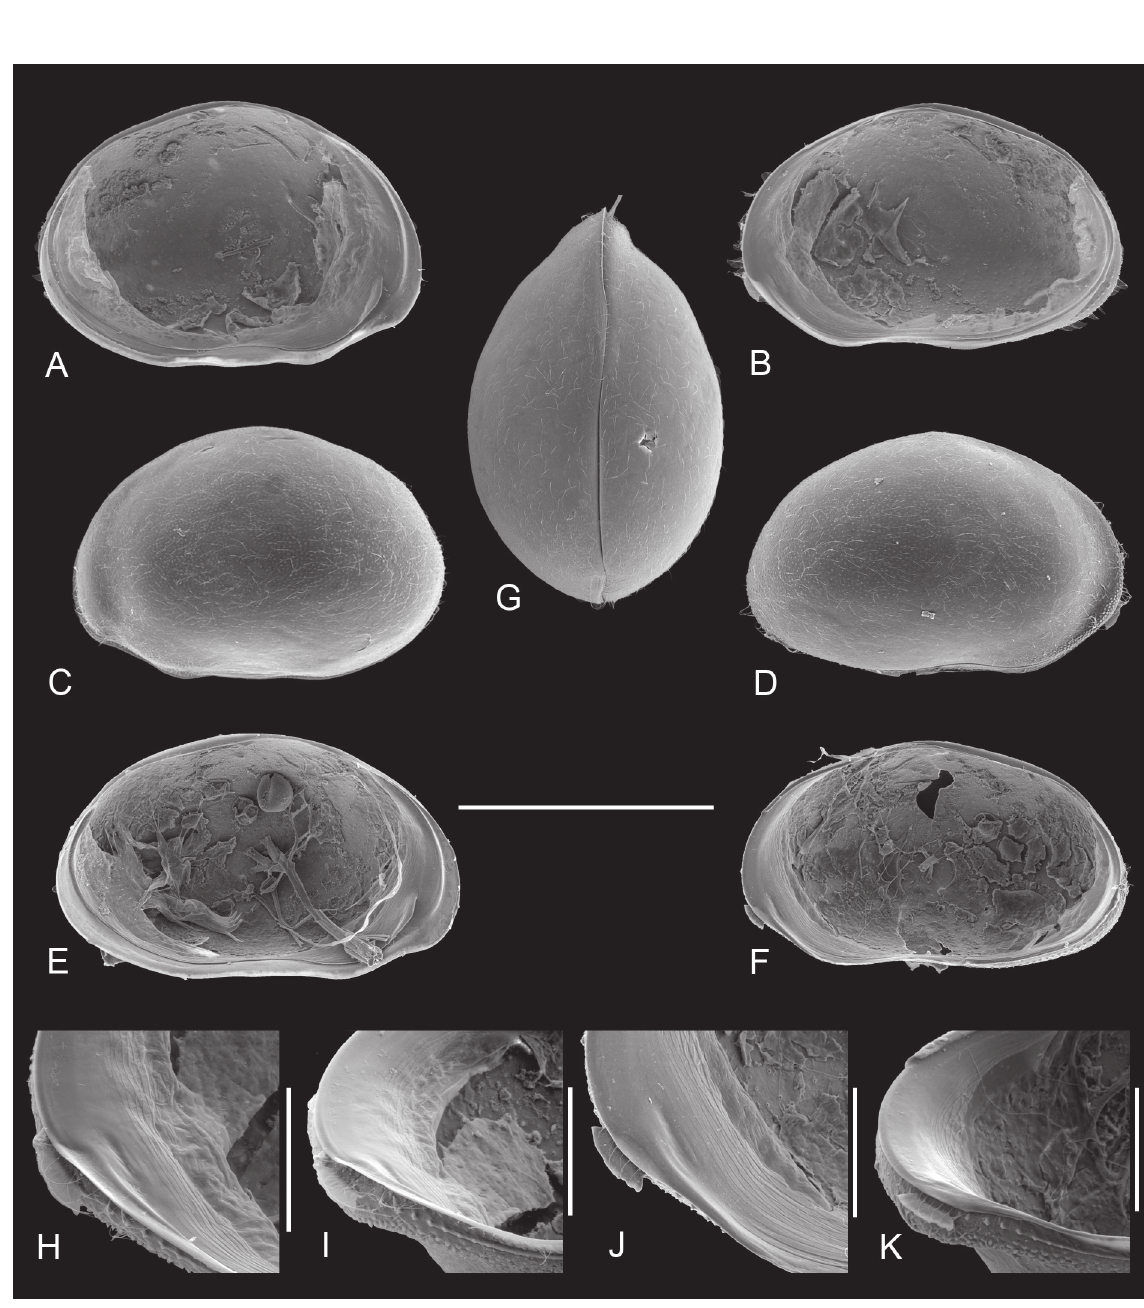
Fig. 12. Bennelongia gnamma sp. nov., type material from type locality (cairn rock, Ostr012a). A . ♀ paratype, LVi (OC.3322). B . ♀ paratype, RVi (idem). C . ♀ paratype, LVe (idem). D . ♀ paratype, rVe (idem). E . ♀ holotype, LVi (WAMC52263). F . ♀ holotype, RVi (idem). G . ♀ paratype, CpD (WaMc52266). H . ♀ paratype, RVi, detail anterior (OC.3322). I . ♀ paratype, RVi, detail anterior, tilted (idem ). J . ♀ holotype, RVi, detail anterior (WAMC52263). K . ♀ holotype, RVi, detail anterior, tilted (idem). scales: a-G = 1 mm; H-K = 200